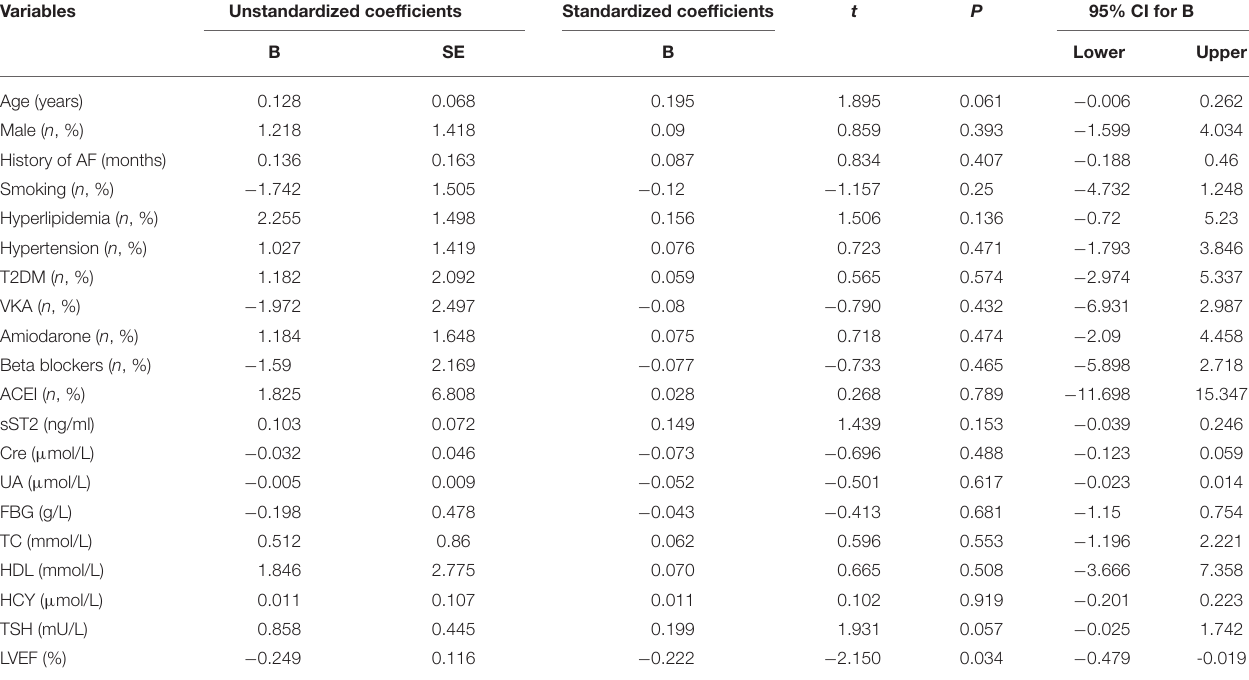
TABLE 5 | Univariate linear regression analyzed the correlations between baseline sST2 and LAVI in paroxysmal AF patients. Variables Unstandardized coefficients